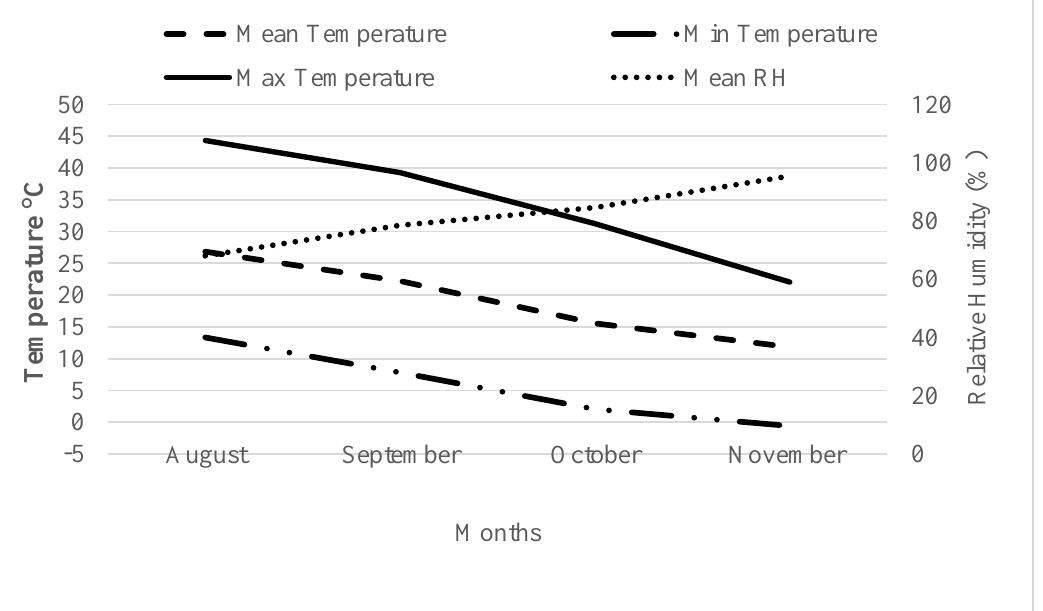
Figure 1. Environmental conditions (mean, max, and min temperature and mean relative humidity (RH)) throughout the experimental period.